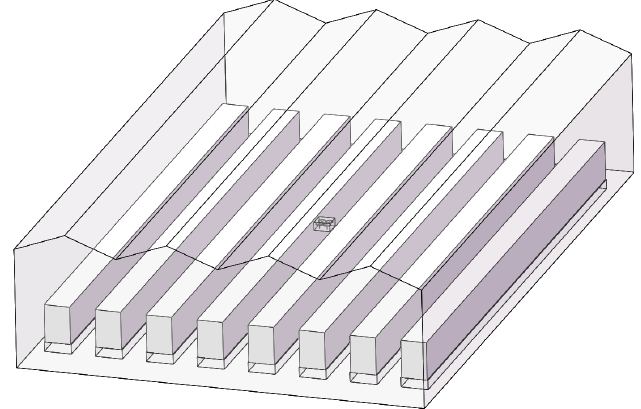
Figure 3. Greenhouse-crop-UAV 3D model.